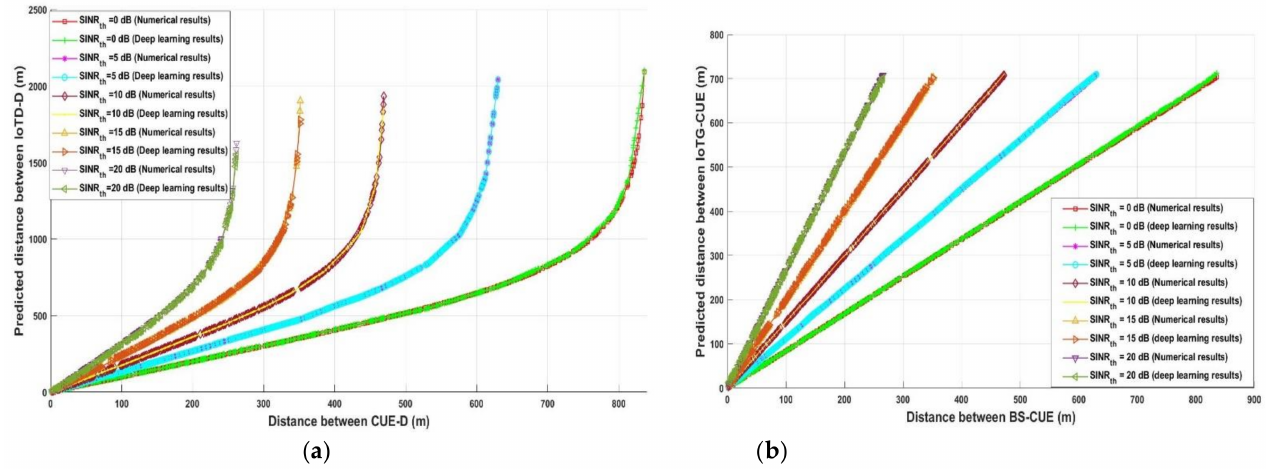
Figure 5. ( a ) Distance between CUE-D versus predicted distance between IoTD-D (uplink) ( b ) Distance between BS-CUE versus predicted distance between IoTG-CUE